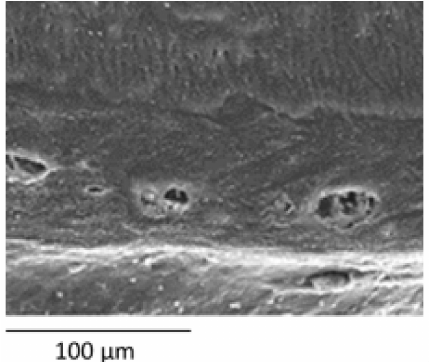
Figure 4. Dentin. SEM photomicrograph with a magnification of 500 × . Pulpar dentin from a subject with OI-I showing an inclusion of giant ovoid structures in the pulpar